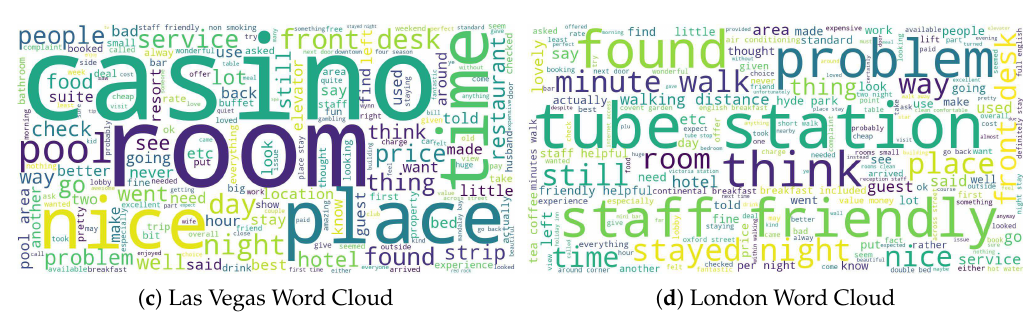
Figure 5. Word Clouds. Table 3. Most influencing POIs for each